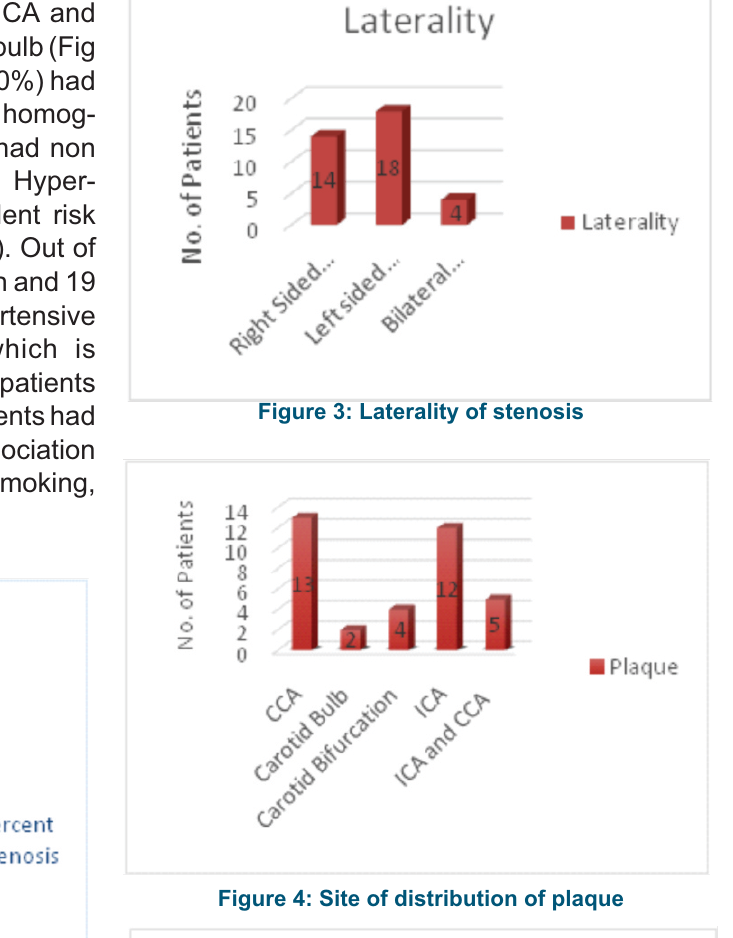
Figure 4: Site of distribution of plaque